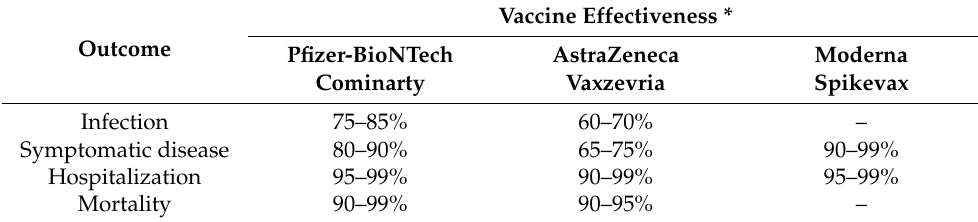
Table 4. Evidence on the effectiveness of the vaccine against various outcomes Delta variant.